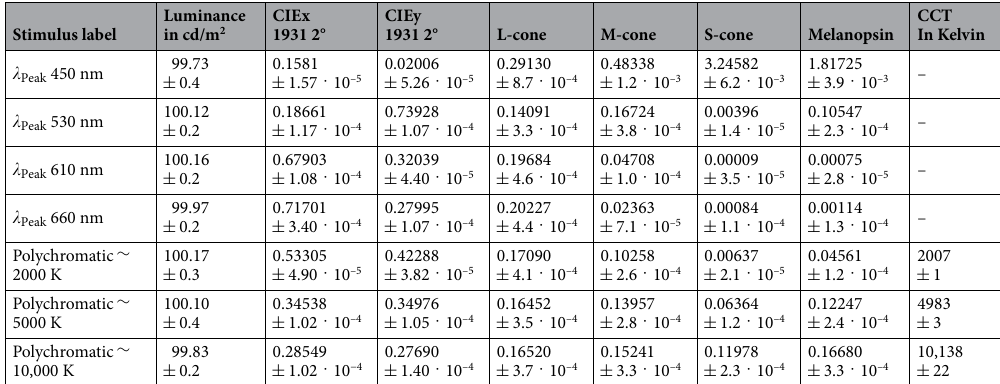
Table 2. Metrics that were used as features for the neural network. The features were calculated from the repeated measured spectra in the pupil examinations 25 . The values are given with standard deviation in the table, but for training the neural network, the mean values were used. On each study day, stimuli were measured twenty times with a Konica Minolta CS-2000 spectroradiometer. S-cone, M-cone, L-cone and ipRGC excitation were calculated with the 10-deg cone fundamentals and the melanopic action spectra reported in CIE S 026/E:2018. The cone and ipRGCs excitation values are specified as α -opic radiance in W/m 2 sr.